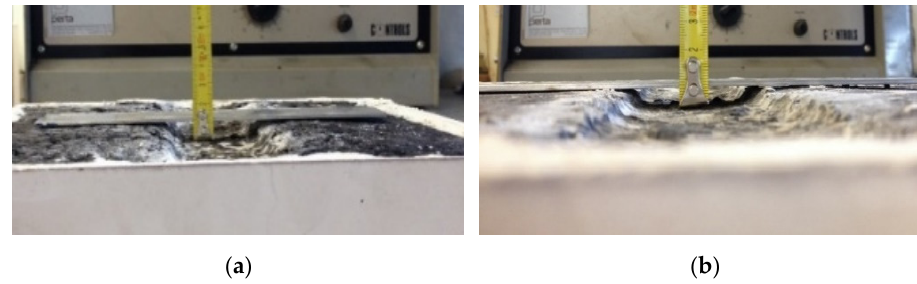
Figure 9. Rut depths of AC 14 mixtures after the WTT test: ( a ) natural aggregates; ( b )